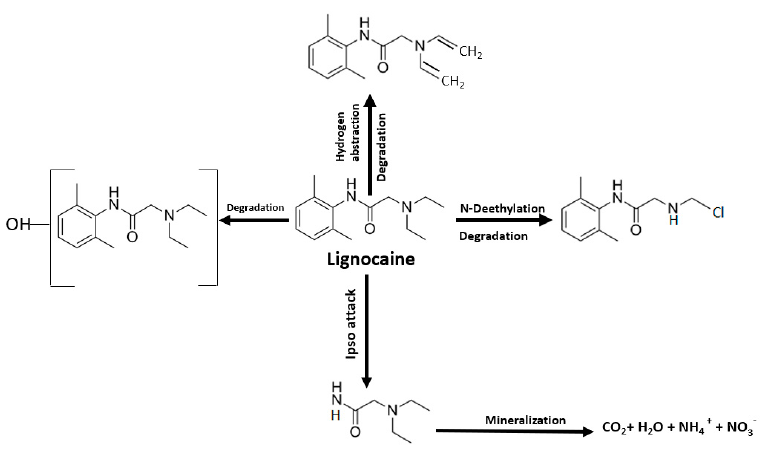
Figure 3. Di ff erent degradation and mineralization products of Figure 3. Different degradation and mineralization products of Lignocaine.